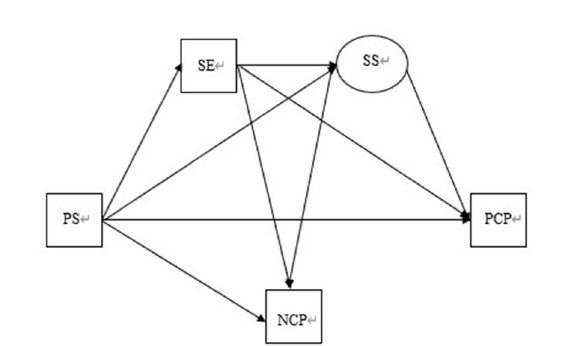
FIGURE1 The multiple mediators of psychological stress and coping style hypothesized: (1) Soldiers’ psychological stress will affect coping style. (2) Self-efficacy significantly mediates the relationship between psychological stress and coping style. (3) Self-efficacy is positively related to social support. (4) Social support significantly mediates the relationship between psychological stress and coping style. (5) Self-efficacy and social support play the role of chain intermediary in the relationship between psychological stress and coping style. PS, psychological stress; SE, Self-efficacy; SS, social support; PCP, positive coping style; NCP, negative coping